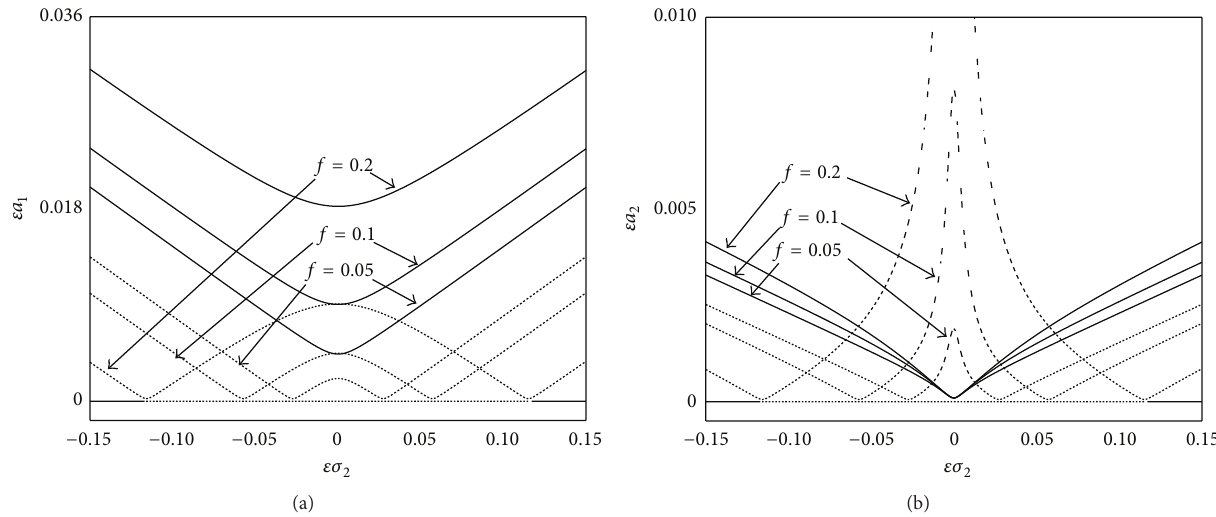
Figure 11: Amplitude-frequency curves of the summation resonance for different external excitation amplitudes: (a) the first mode and (b) the second